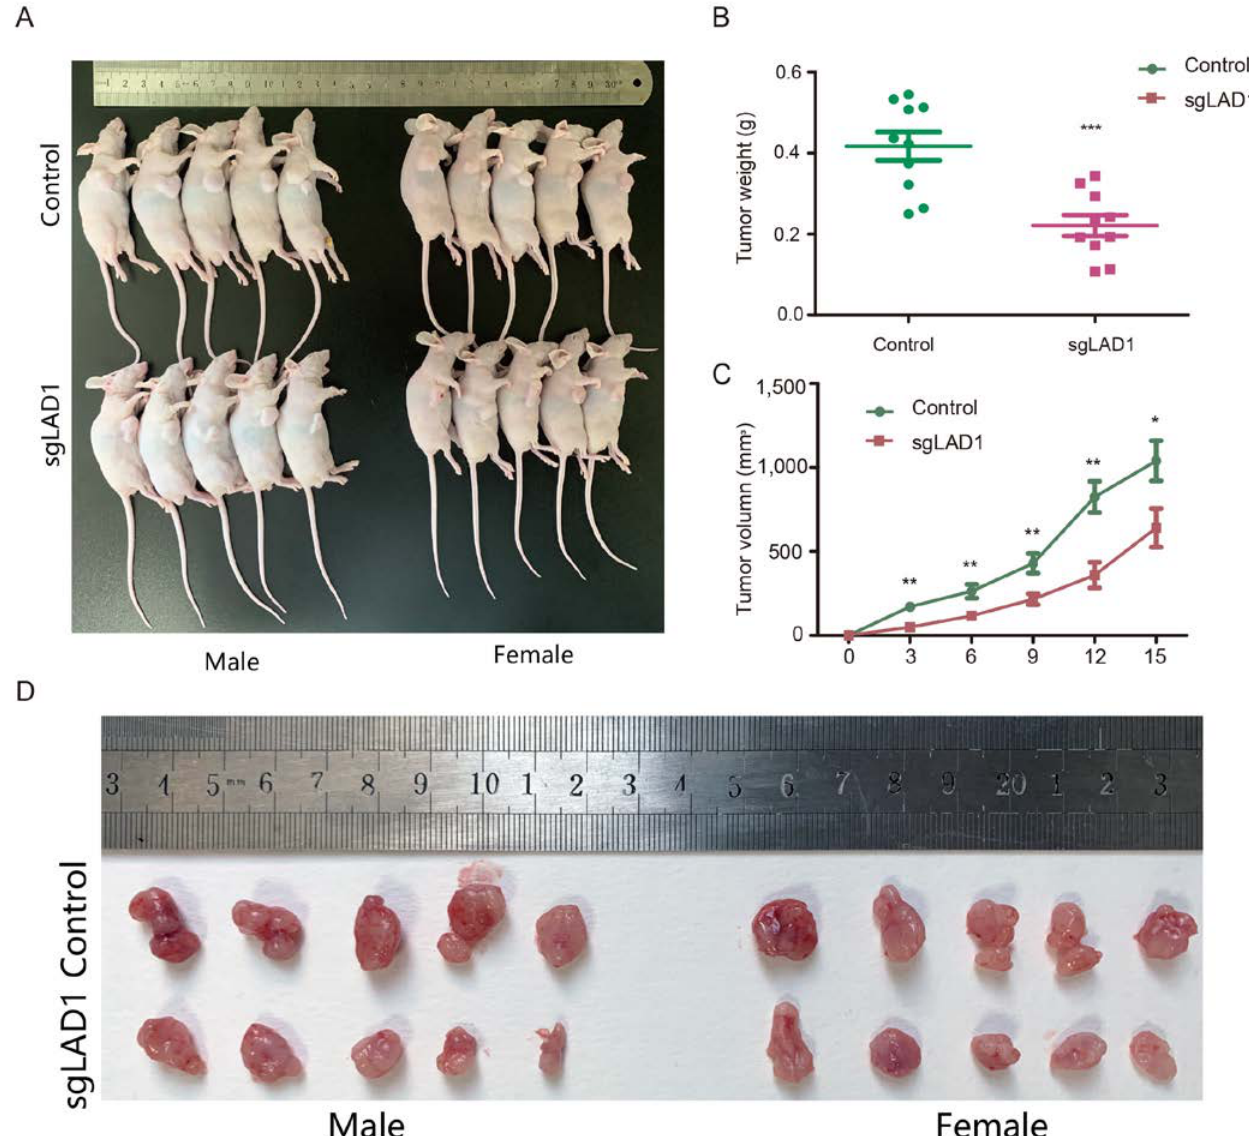
Figure 8. LAD1 depletion reduces tumorigenicity in the xenograft model. Control and mixed LAD1- knockout cells (sgLAD1 #1 and #2 mixed at 1:1) were separately inoculated subcutaneously into Balb/c nude mice ( A ). The tumor sizes were quantified at different time points after inoculation ( B ). Two weeks after implantation, the tumors were weighed ( C ), and images of the transplanted tumors are displayed ( D ). Error bars, means ± SD (* p < 0.05, ** p < 0.01, *** p < 0.001 vs. control).